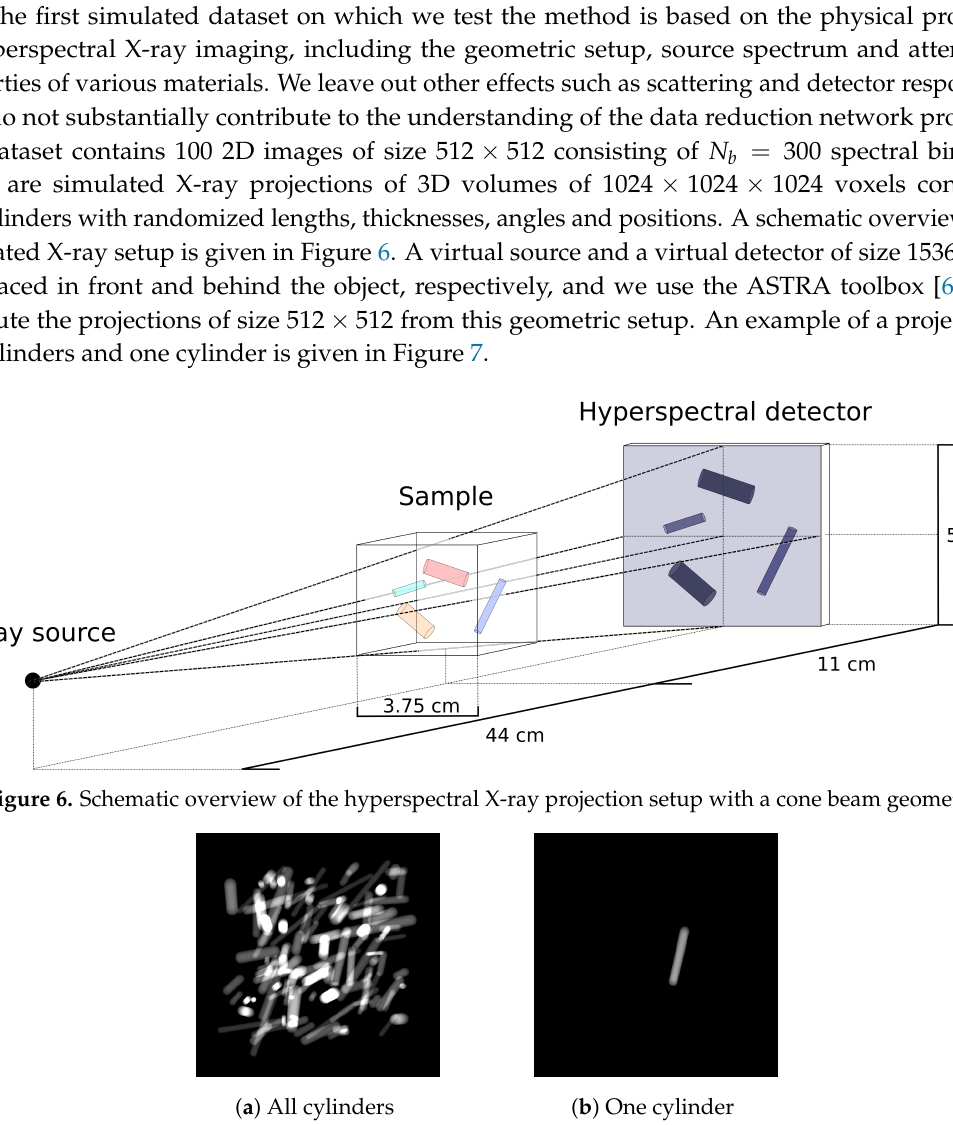
Figure 7. Example of the simulated material projections before material designation. The cylinders are shown to be all combined in one image ( a ), and separately ( b